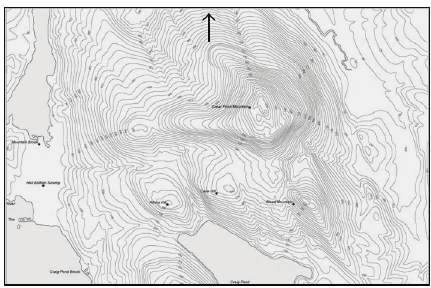
Figure 3: A map with contour [19].